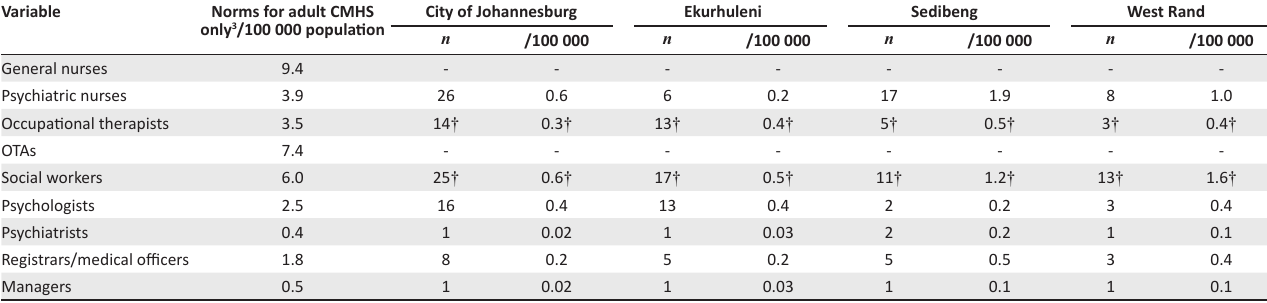
TABLE 3: Human resources serving adult and child and adolescent Community Mental Health Services.